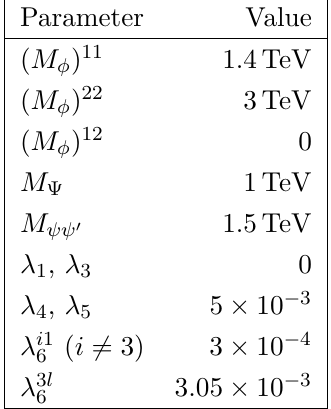
Table 2 . Mass parameters and couplings used in (cid:12)gure